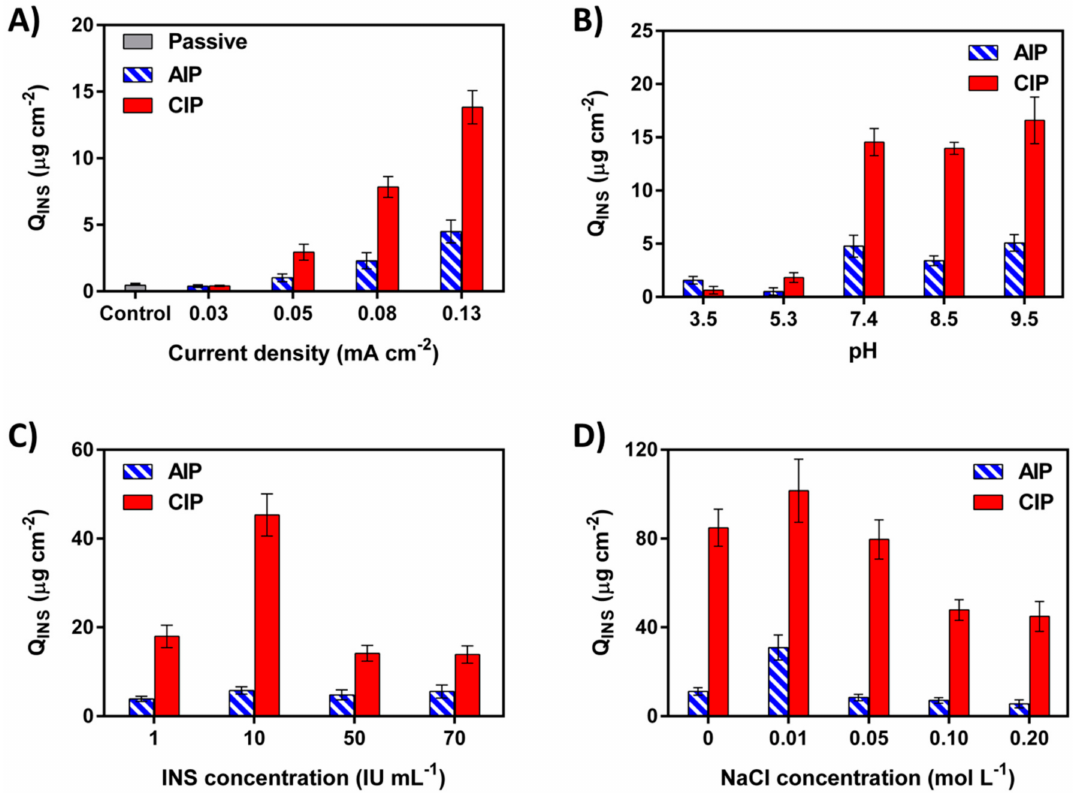
Figure 4. The effect of ( A ) current density, ( B ) formulation pH, ( C ) INS concentration, and ( D ) sodium chloride concentration on the AIP and CIP of INS from INS-loaded